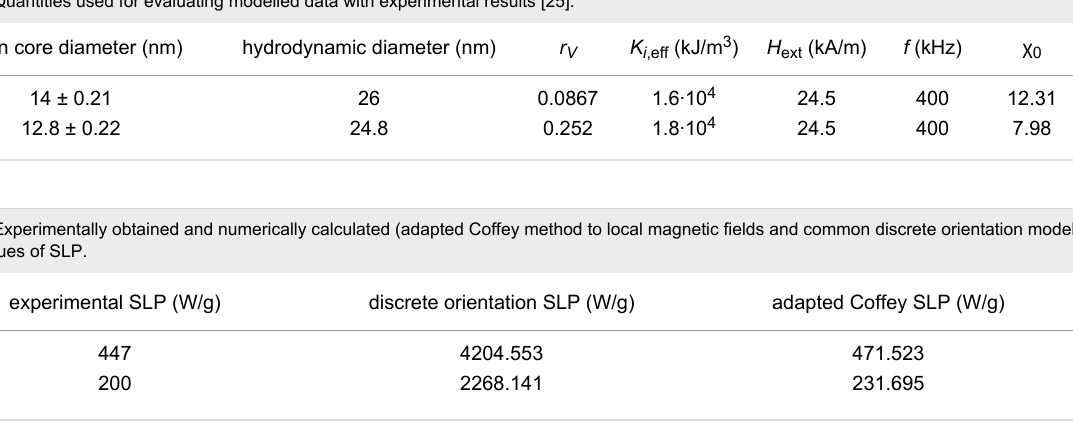
Table 1: Quantities used for evaluating modelled data with experimental results [25].